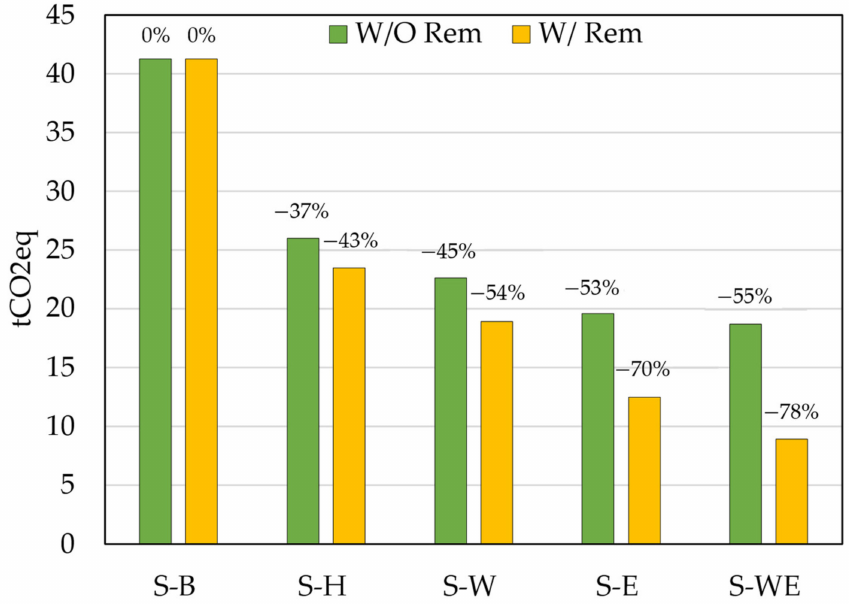
Figure 9. Tons of CO 2 eq emissions for scenarios without and with incentives on shared electricity. Percentage values indicate the emission percentage reductions compared with